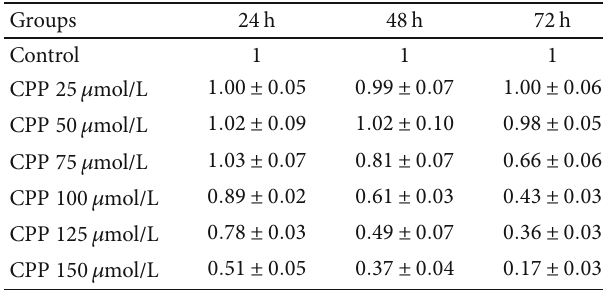
Figure 3: CPP inhibits U251 cell viability. (a – c) Changes in cell viability after 24, 48, and 72h of CPP treatment (25, 50, 75, 100, 125, and 150 μ mol/L) at di ff erent concentrations. Compared with the control group, ∗ indicates p < 0 : 05 . This experiment was repeated three times independently. Table 1: U251 cell viability changes under di ff erent concentrations and time of CPP